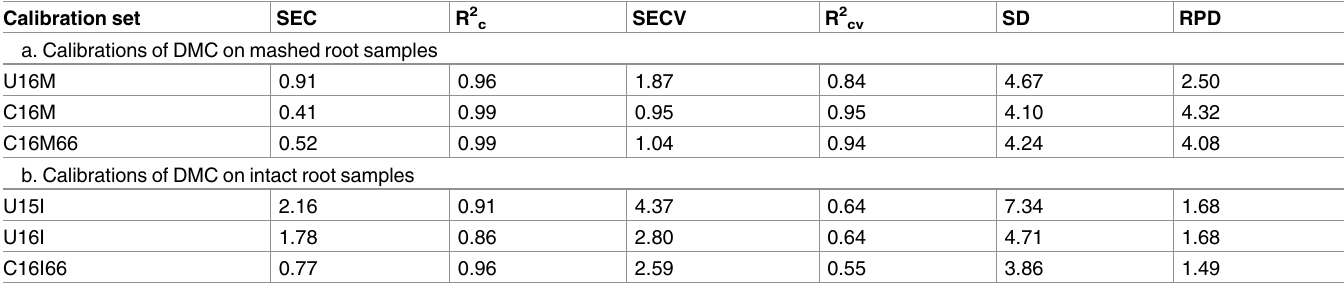
Table 4. Calibration assessments of DMC from different calibration sets on mashed (a.) and intact (b.) root samples for DMC. Calibration